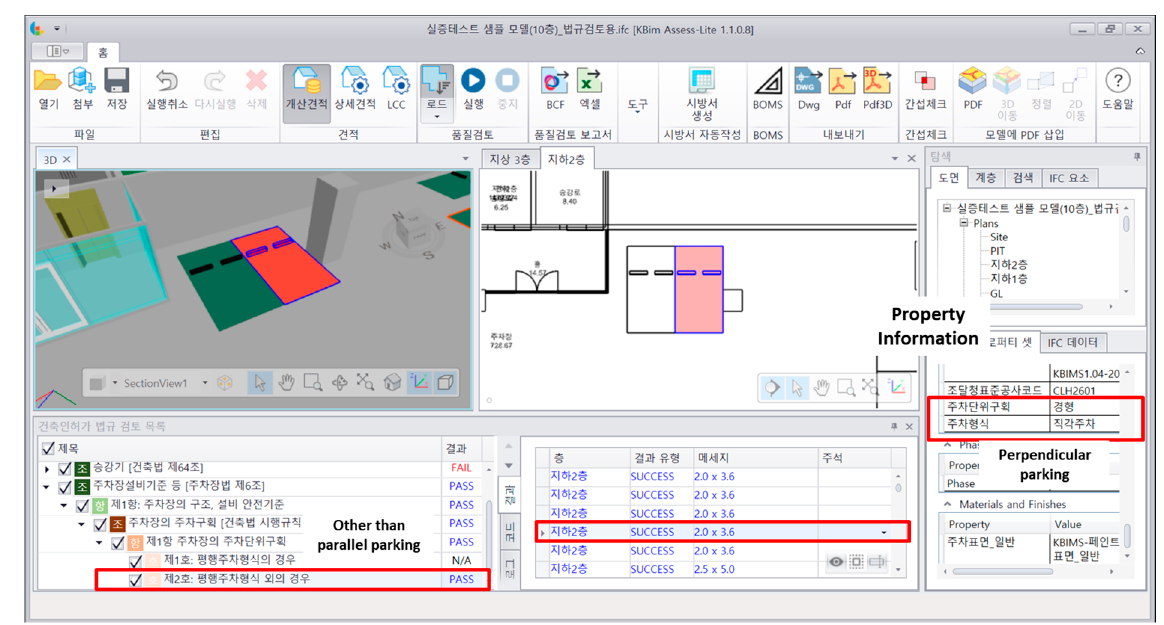
Figure 13. Code checking screen: evacuation stairs’ parking lot conditions.